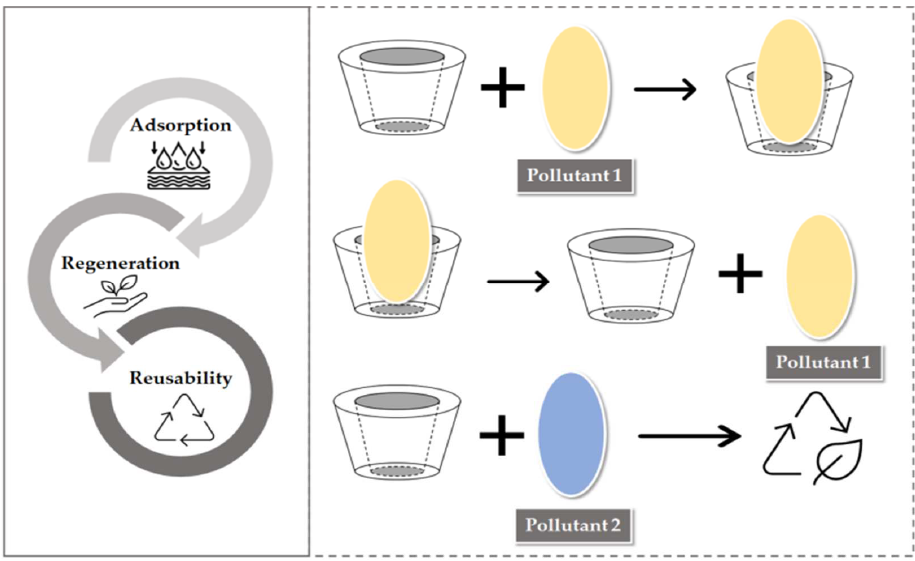
Figure 8. Schematic diagram of adsorption-regeneration-reusability.